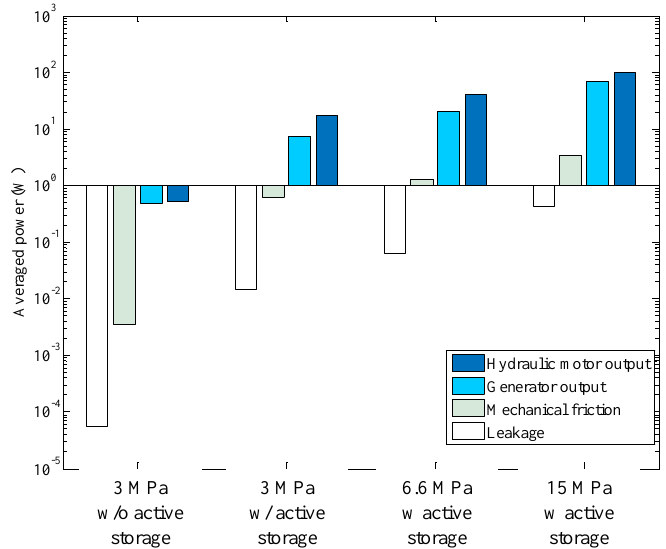
Figure 13. Simulated averaged power under realistic wave input. Note the time series of surface elevations data was recorded by a wave buoy at the South West UK, on 18 March 2010, 15:00, published in [26]. The peak frequency of the wave is 0.05 Hz and the maximum amplitude is 5 m. A saturation operation was applied to the wave trajectory to limit input to piston displacement between 0 mm and 25 mm. Additionally, a total duration of 430 s of data was used so that 50 completed piston input cycles were achieved to match that of Figure 12. The averaged output electrical power of the four cases are 0.5 W, 7.3 W, 20.2 W, and 69.1 W.